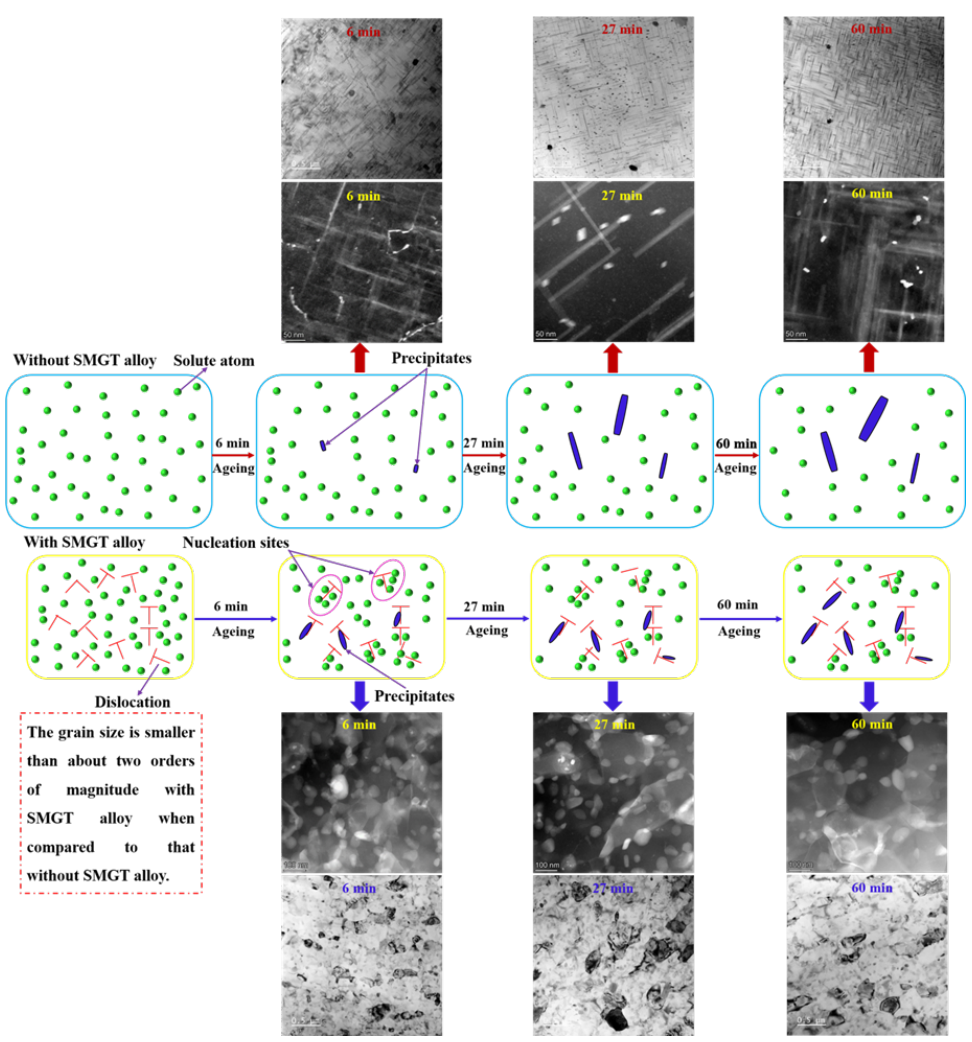
Figure 13. Schematic illustration of the evolution of precipitation inside the grain with and without SMGT alloys under 210 ◦ C aging for 6, 27, and 60